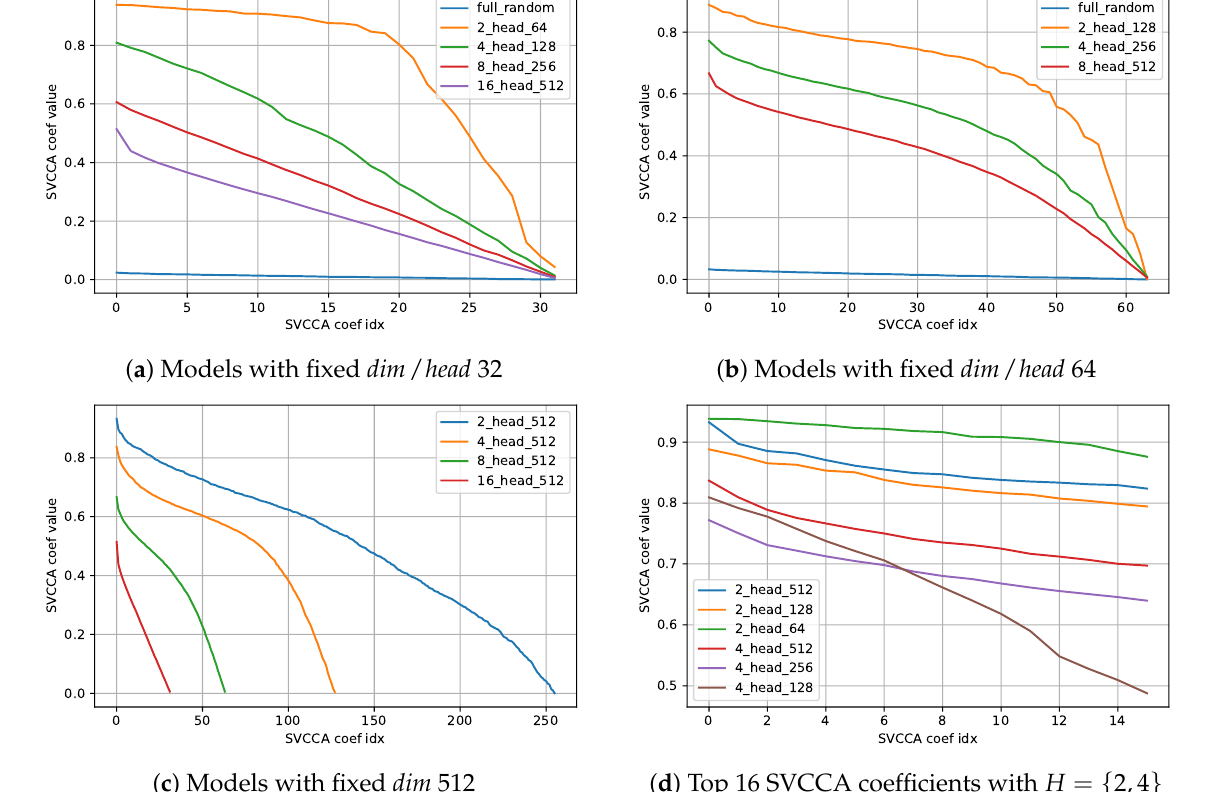
Figure 3. SVCCA coefficient curves of inter-head